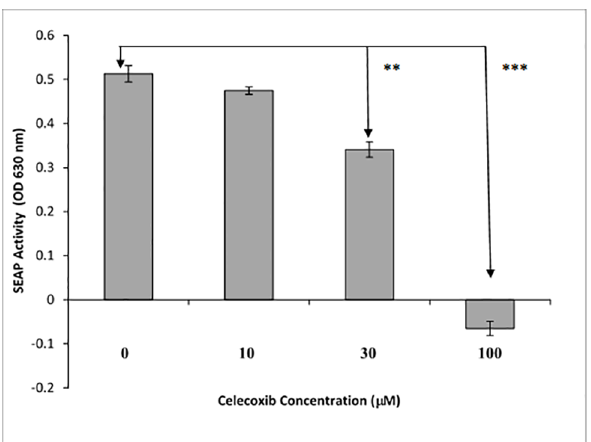
Fig 9. Celecoxib inhibits TNF α -induced activation of HEK-TLR4 cells in a dose-dependent manner. HEK-TLR4 cells were treated with varyingconcentrations of celecoxibfor one hour after which cells were stimulatedwith TNF α (2 μ g/well). After overnightincubation, SEAP activity was measuredto evaluatecellular activation. Significance is represented by the asterisks, p (cid:20)